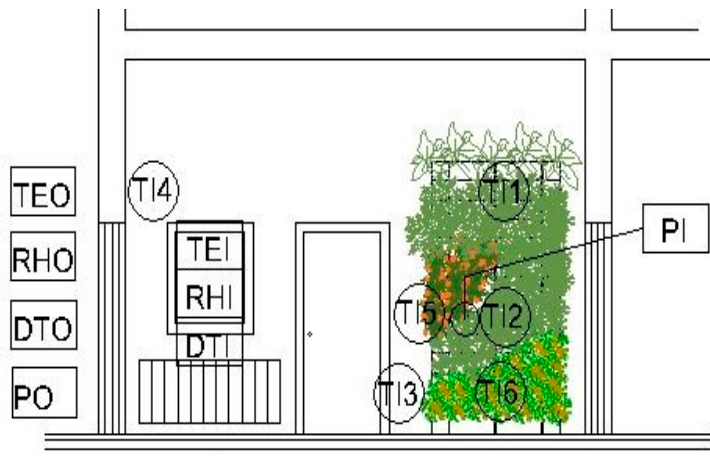
Figure 5. Scheme of locations of sensor used for measurement.